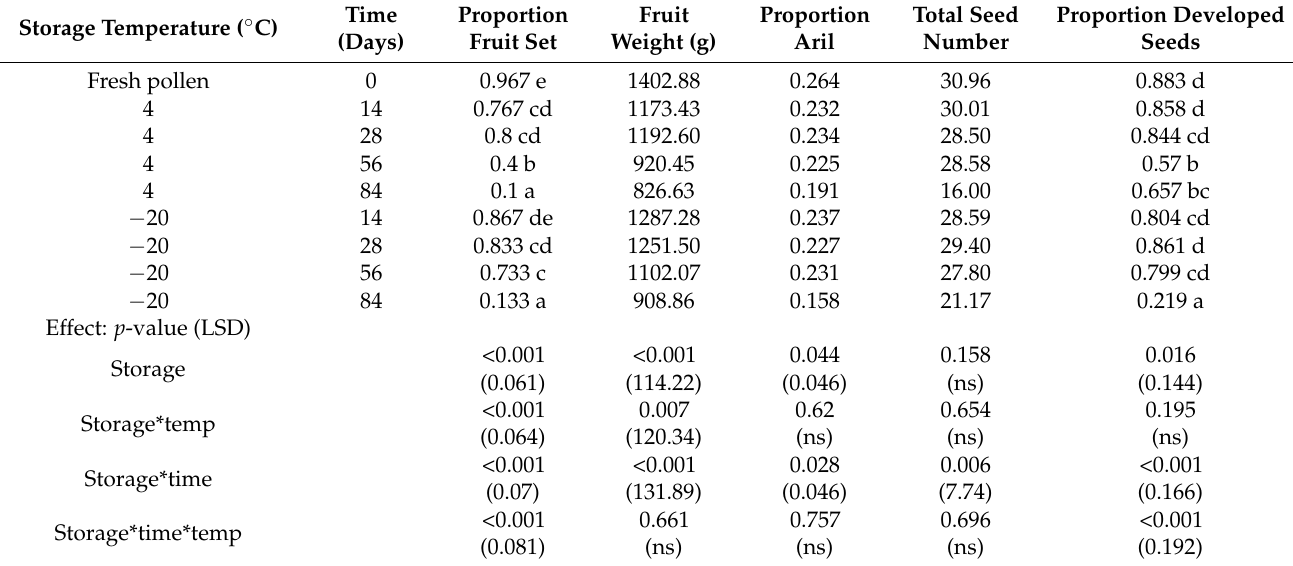
Table 1. Fruit set and some physical characteristics of Gac aril from fruits originally pollinated with fresh and cool-stored pollen. Values are means ( n = 3) and the significant effects of factors and their interactions are included. The same letters following means within a column are not significantly different. Means are separated when all factors significantly interact. (ns—not significant, temp—temperature, LSD-least significant difference).